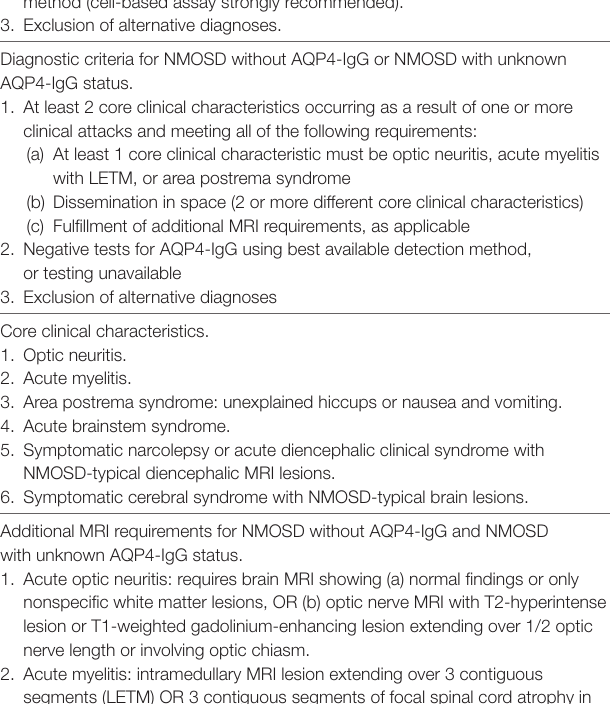
TAble 2 | Neuromyelitis optica spectrum disorder diagnostic criteria from Ref. (23). Diagnostic criteria for NMO spectrum disorder (NMOSD) with aquaporin-4 (AQP4)-IgG. 1. At least 1 core clinical characteristic. 2. Positive test for AQP4-IgG using best available